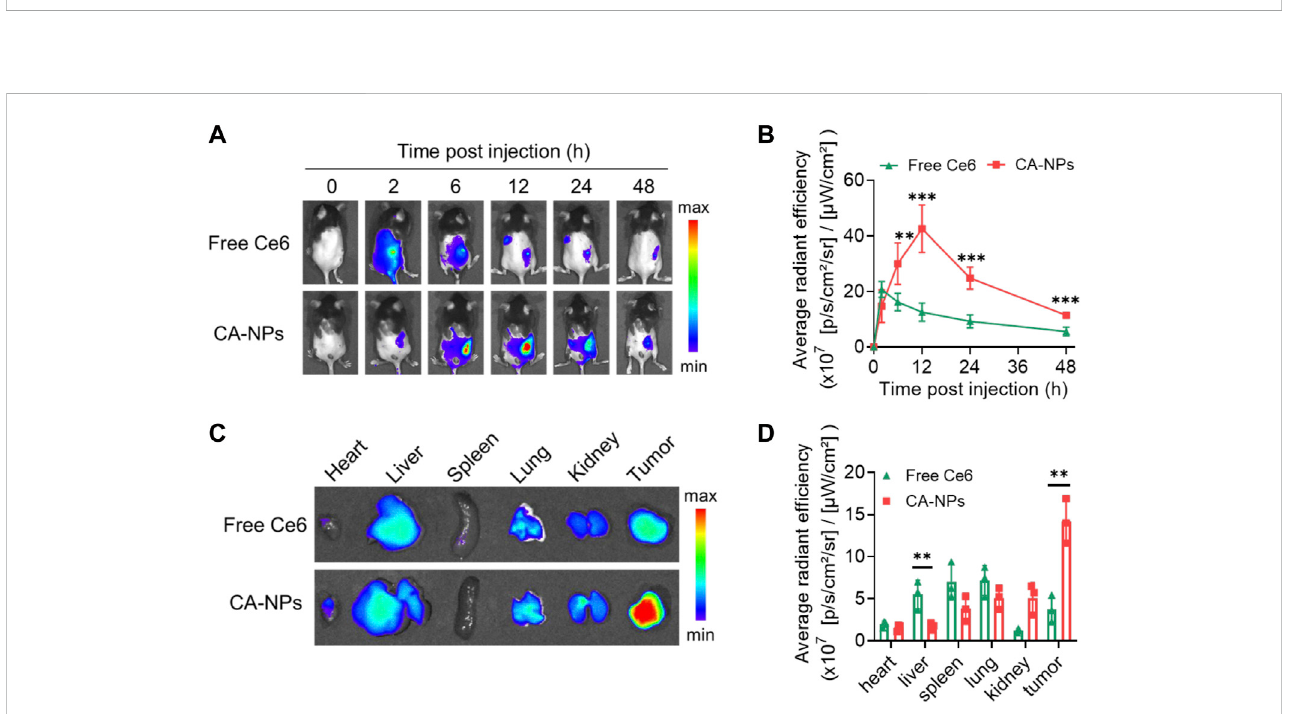
FIGURE 4 In vivo targeting ability of CA-NPs (A,B) In vivo fl uorescence images and fl uorescence intensities at tumor sites of MB49 tumor-bearing mice with intravenous injection of free Ce6 and CA-NPs at the dose of 5.0 mg/kg during 48 h (n = 4; ** p < 0.01, *** p < 0.001). (C,D) Ex vivo fl uorescence images and fl uorescence intensities of various tissues extracted at 12 h from MB49 tumor-bearing mice with intravenous injection of free Ce6 and CA-NPs. (n = 3; ** p <